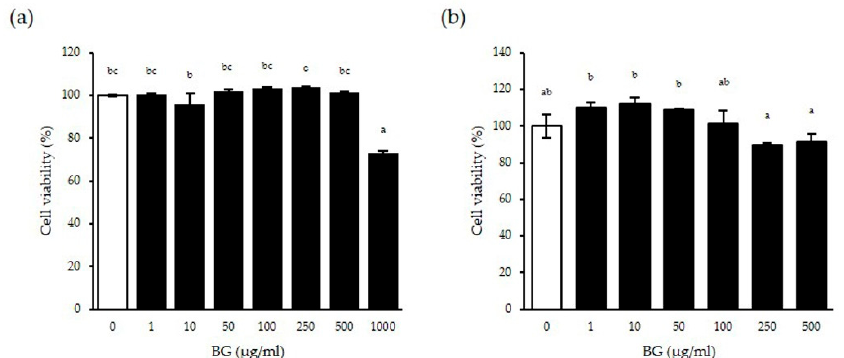
Figure 1. Effect of BG on cell viability in vitro. Cell viability was measured on wild-type mouse embryo fibroblast (wt MEF) for 24 h ( a ) and Caco-2 cells for 48 h ( b ) with the indicated concentration of BG. Cell viability of the negative control cells set as 100%. At least three independent experiments were performed. Data are expressed as means ± SD. Significant differences between different concentrations were analyzed using Duncan’s multiple range test with one-way ANOVA, and values labeled with different letters are significantly different ( p < 0.05). White bar represents negative control. BG, black ginseng.